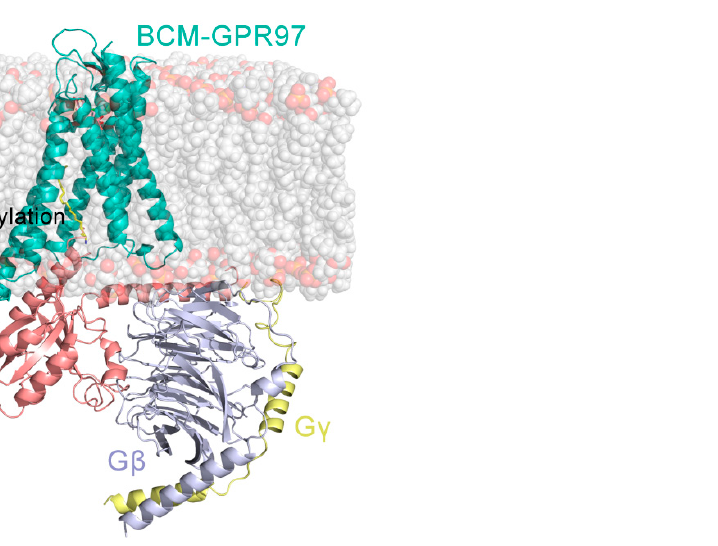
Figure 1. Orthogonal view of the model of the BCM–GPR97–Go complex. GPR97 is shown in light sea green, G α o in salmon, G β in light blue, G γ in yellow, and BCM in pink.